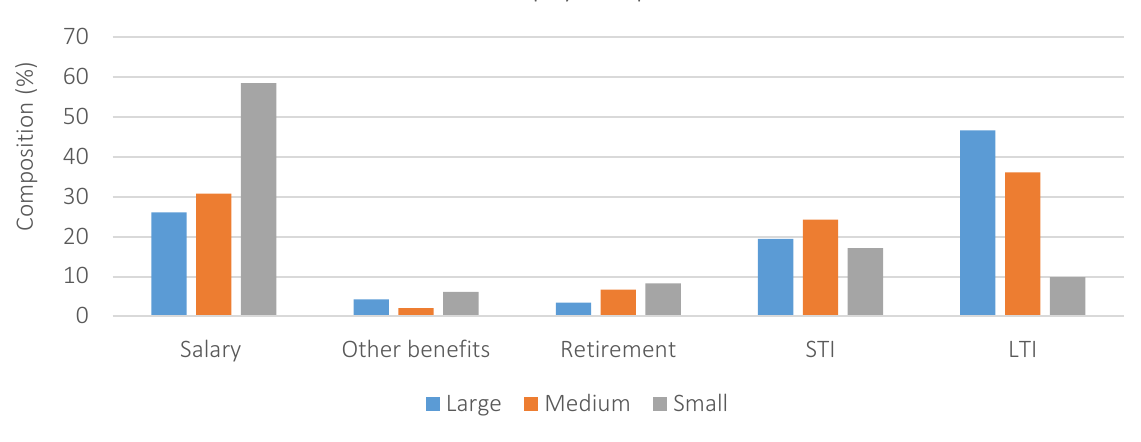
Figure 1. Executive pay